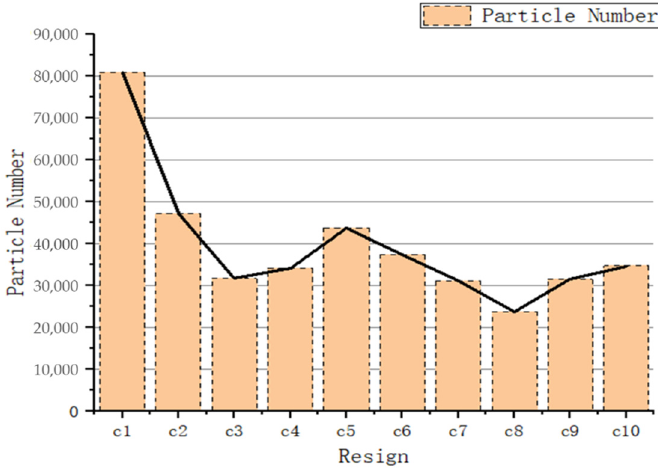
Figure 24. Number of particles in c1~c10.